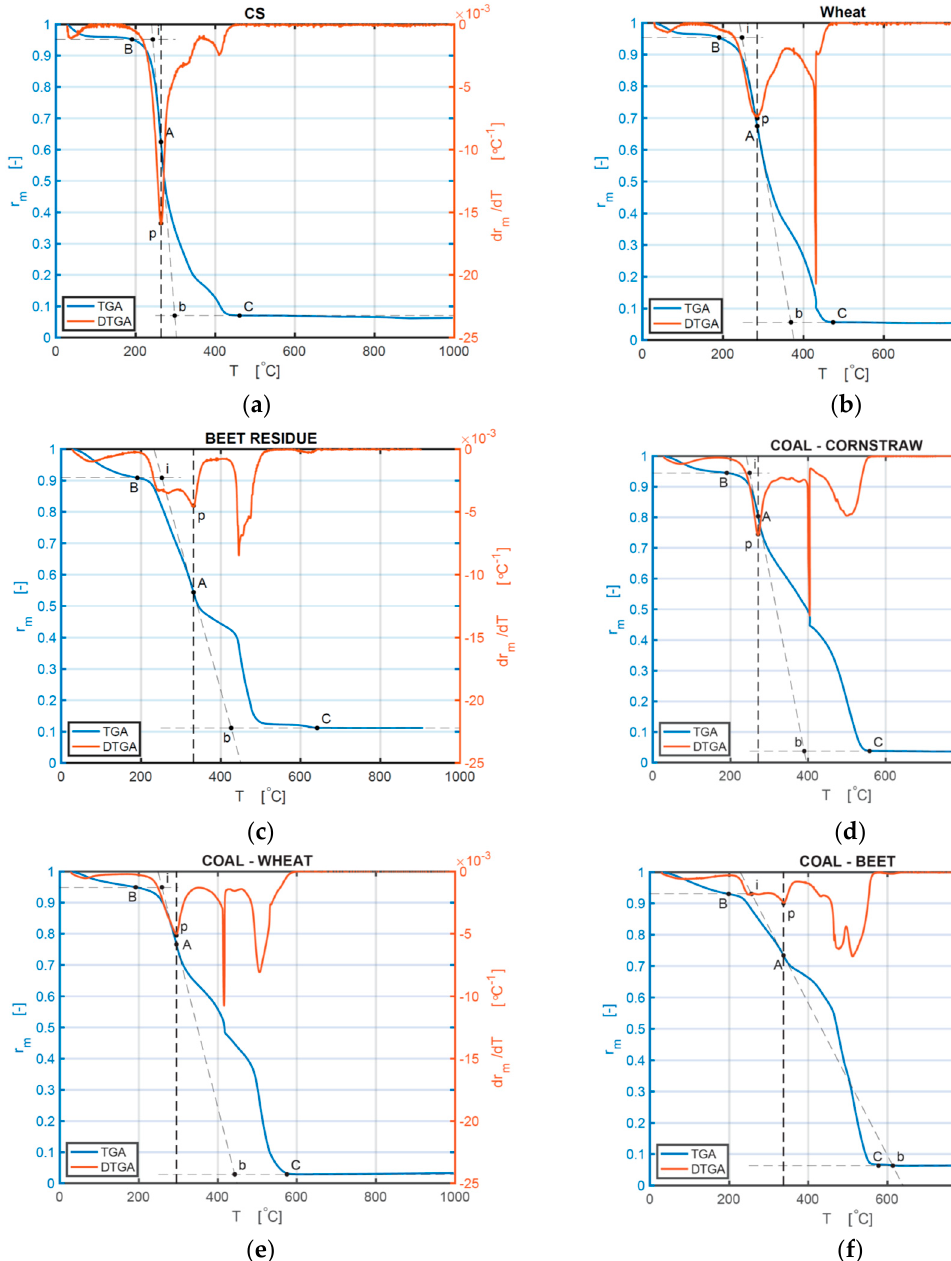
Figure 1. TG and DTG curves of the coal sample under 10 °C/min. The TG and DTG curves of other samples are shown in Figure 2a–f. The TG and DTG curves of other samples are shown in Figure 2a–f.